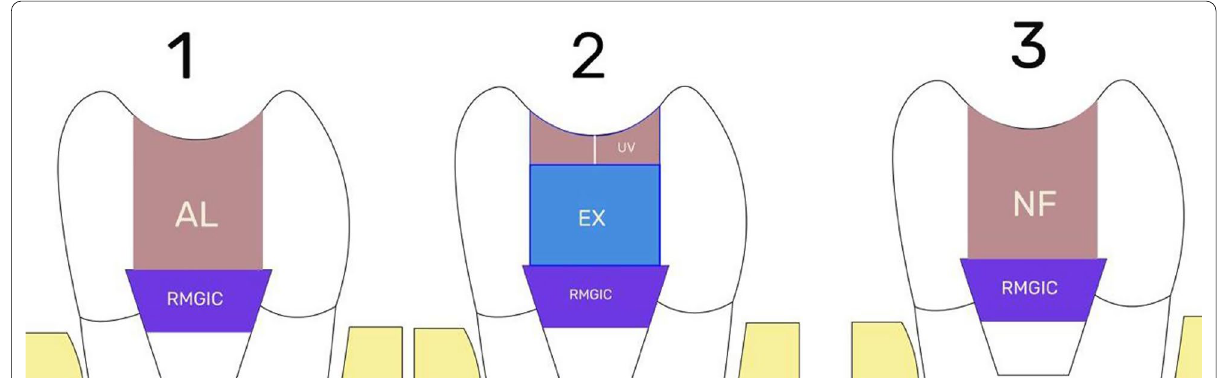
Fig. 1 Illustration of different restoration groups in tooth model: pulp chamber was filled with resin-modified glass ionomer cement (RMGIC) in the 3 groups. Group 1, coronal restoration with Alert fiber-reinforced resin composite (AL); Group 2, coronal restoration with Ever X flow fiber-reinforced (Ex) followed by 1 ml of universal composite (UC); and Group 3: coronal restoration with nano-filled resin composite